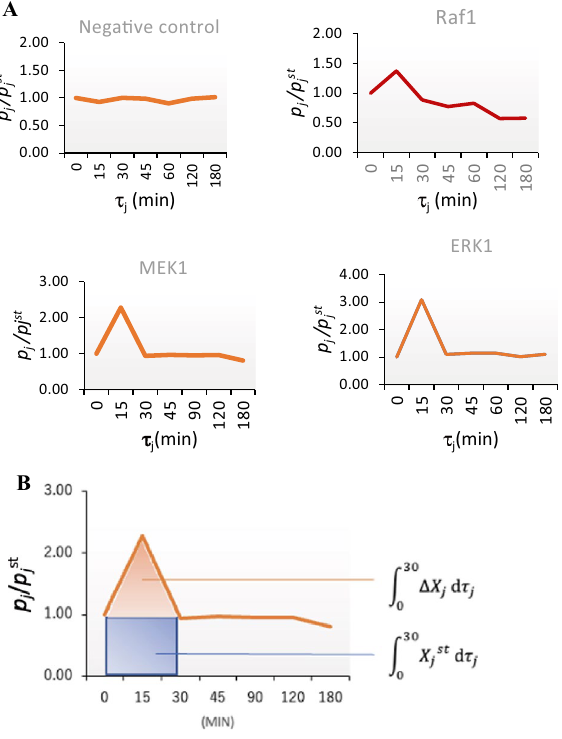
Figure 1. ( A ) Time course of the phosphorylation of signaling molecules in starved A431 cells. The ratio p j / p j st = X j / X j st is shown on the y -axis, and the time after epidermal growth factor (EGF) stimulation (min) is shown on the x -axis. Plots of actual experimental time-course data are provided (S1 Data and S2 Data). The negative control, Raf1, MEK1, and ERK1 plots represent the ratio intensity. The typical time course pattern indicates that the phosphorylation of one signal molecule increases from t = 5 to 15 min after stimulation and declines from t = 15 to 45 min. ( B ) Time course of phosphorylation of the signal molecule X j . Information entropy gain ΔI j (= log p j / p j st ) was calculated using the ratio ∫ 0 τ j ( ΔX j + X j st ) dt /∫ 0 τ j X j st dt . In this case, τ j = 30